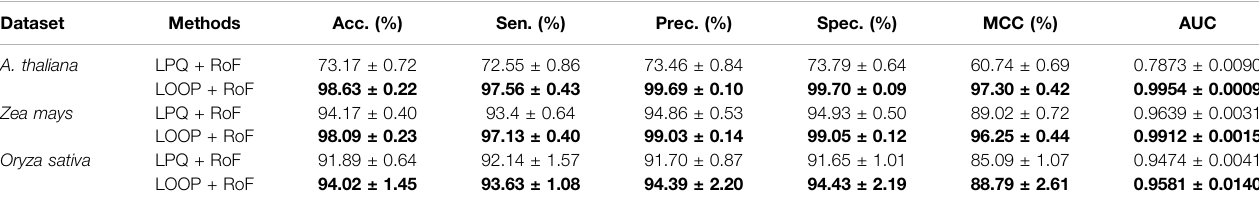
TABLE 5 | The fi vefold cross-validation results achieved on the three plant PPIs dataset among different descriptors using the proposed method.